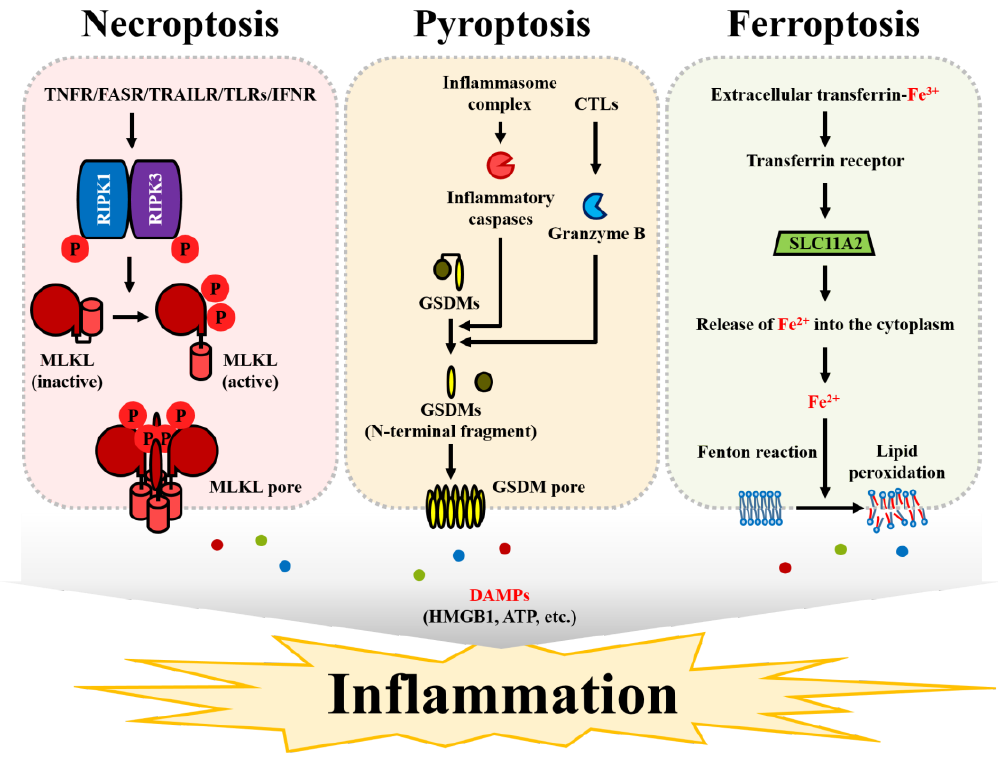
Figure 2. Types of RNCD. Necroptosis can be induced by the signals of TNF receptors, FAS receptors, TRAIL receptors, toll-like receptors, and interferon receptors. In the absence of caspase-8 activity, the phosphorylation of RIPK1 and RIPK3 induces phosphorylation and the subsequent activation of inactive MLKL. Activated MLKL is translocated into the plasma membrane and forms the pores approximately 4 nm in diameter. Pyroptosis is caused by gasdermin-mediated pore formation. The activation of the inflammasome complex induces the enzymatic activity of caspase-1, and caspase-1 cleaves gasdermin D. The N-terminal region of cleaved gasdermin D is translocated into the plasma membrane and forms the pores approximately 10–15 nm in diameter. In addition to caspase-1, gasdermin proteins can be cleaved by caspase-4, caspase-5, and caspase-11. Moreover, gasdermin E can be cleaved by granzyme B, which is released by cytotoxic CD8 T cells and natural killer (NK) cells. Ferroptosis is caused by membrane disruption induced by an iron-mediated lipid peroxidation process known as the Fenton reaction. Transferrin receptor transfers Fe 3+ bound to extracellular transferrin into the intracellular endosomal regions. Fe 3+ is reduced to Fe 2+ by STEAP3, a ferrireductase, and generated Fe 2+ is released into the cytoplasm by SLC11A2 (also known as divalent metal transporter 1, DMT1). The release of Fe 2+ into the cytosol causes lipid peroxidation in the plasma membrane. As a result of RNCD induction, DAMPs, such as HMGB1 and ATP, can be released into the extracellular regions to induce inflammatory responses in the tissues.